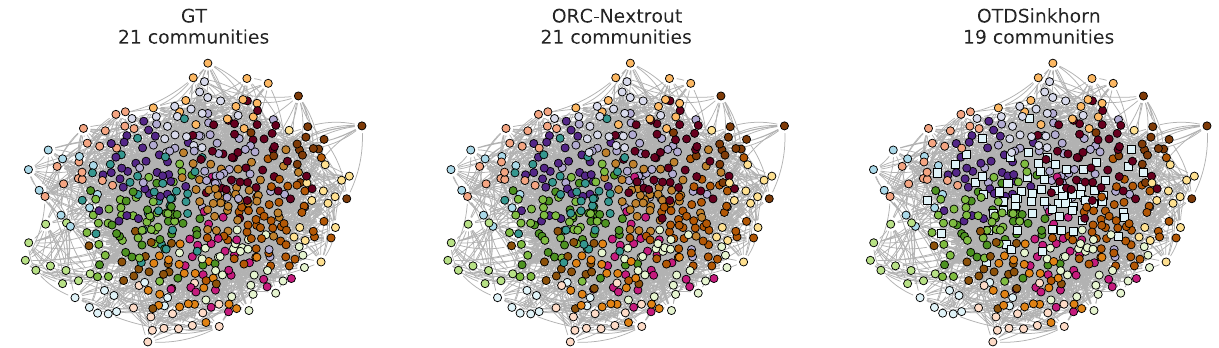
Figure 4. Example of community structure on a synthetic LFR network. The rightmost panel shows the ground-truth community structures to be predicted in an LFR network generated using µ = 0.35 . This network is one sample of the synthetic data used in Fig. 3. Square-shaped markers denote nodes that are assigned to communities different from those in ground-truth. In the middle and last panels, ORC-Nextrout with β = 2 perfectly retrieves the 21 communities, while OTDSinkhorn predicts only 19 communities with an ARI score of 0.73, wrongly assigning ground-truth dark green and light brown (square-shaped) nodes to the light blue community.